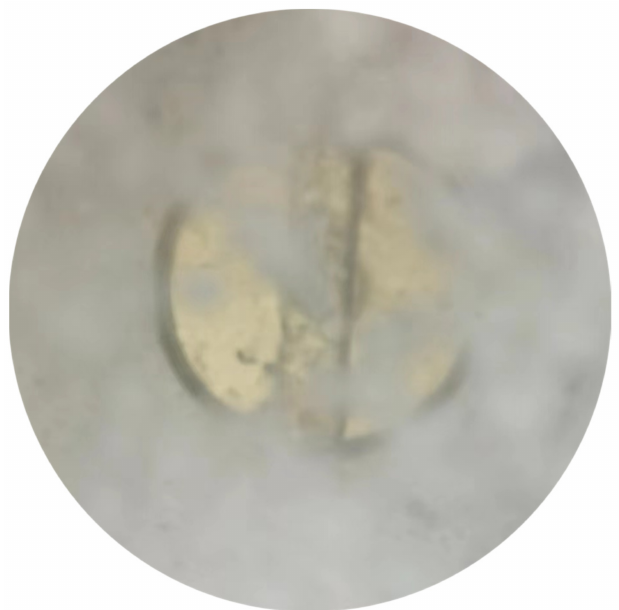
Figure 13. Conditions in the kettle after the